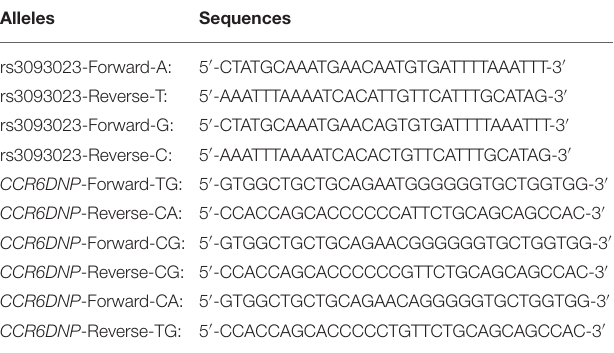
TABLE 1 | Oligonucleotide probes for